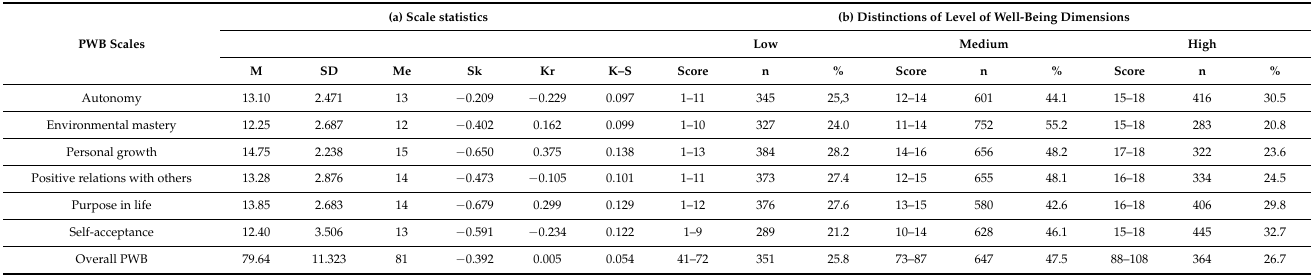
Table 1. Descriptive results of the study—assessment of psychological well-being during the COVID-19 outbreak in the experiences of Polish, Croatian, and Lithuanian students. ( a ) Raw re- sults on the Ryff’s PWB Scale; M = mean, SD = standard deviation, Me = median, Sk = skewness [standard error = 0.066], Kr = kurtosis [standard error = 0.133], K–S = Kolmogorov–Smirnov nor- mality test [for all K–S statistics p < 0.001]. ( b ) Distinctions of the level of well-being derived from distributional information from the collected data (aimed according to the quartiles of 25%, 50%, and 25%). Here, n =